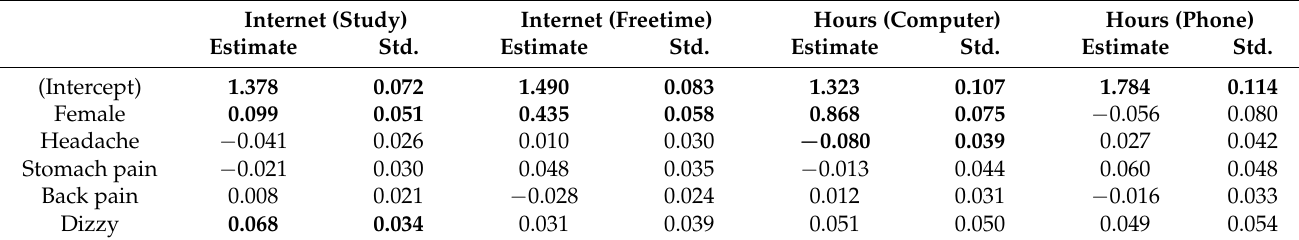
Table 2. Regression coefficients for somatic symptoms models.